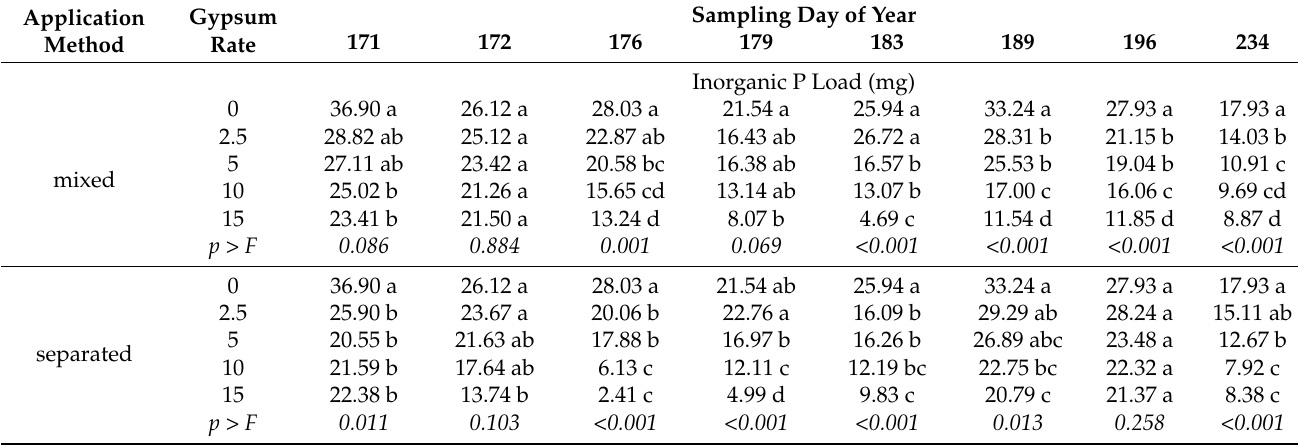
Table 4. Temporal changes in dissolved P leaching load observed over time from containers in 2019 as affected by